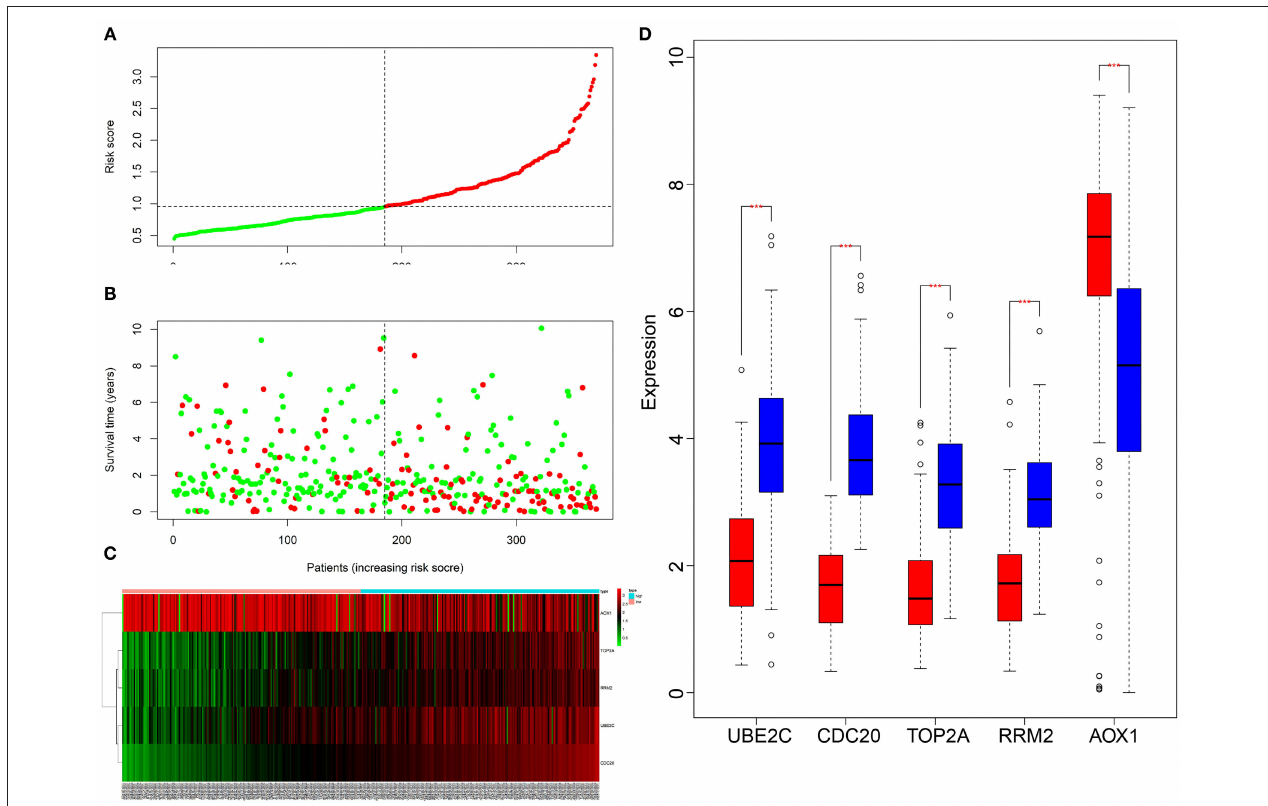
FIGURE 9 | Multivariate Cox analysis of the correlation between five key genes and the prognosis of HCC patients. (A) , The patients were assigned into low-risk group and high-risk group. The red X-axis represents the number of patients and the Y-axis represents the risk score. (B) , Survival rats of patients, Each dot in the graph represents a patient. The red point represents a patient who had died during follow-up, and the green point represents a surviving patient. The X-axis represents the sample increasing with the risk score, and the Y-axis represents the survival time of the patient. (C) , The X-axis represents the sample number, the Y-axis represents the gene name, and the upper right histogram is the color scale. (D) , The X-axis shows the gene name, and the Y-axis shows the expression; the red box chart shows the low-risk samples, and the blue box chart shows the high-risk samples (** p < 0.001).